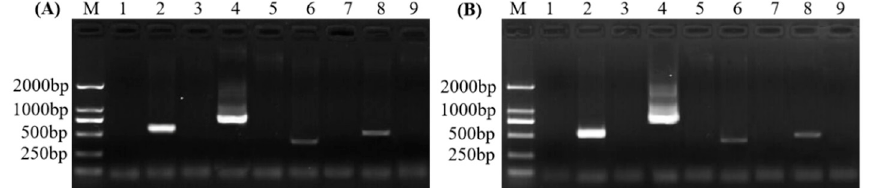
Figure 2. Results of nested PCR using the universal primer ( A ) R16mF2/R16mR2 or ( B ) R16F2n/R16R2, followed by four pairs of candidate-specific primers for SPLDaP detection in sisal. The even numbers (2, 4, 6, 8) of lanes are SPLDaP-positive samples, and the odd numbers (3, 6, 7, 9) of lanes are SPLDaP-negative samples. Lane M: marker DL2000; lane 1: negative control; lanes 2–3 ( A , B ): specific primers ASF1/ASR1; lanes 4–5 ( A , B ): specific primers ASF1/ASR2; lanes 6–7 ( A , B ): specific primers ASF2/ASR1; lanes 8–9 ( A , B ): specific primers ASF2/ASR2.